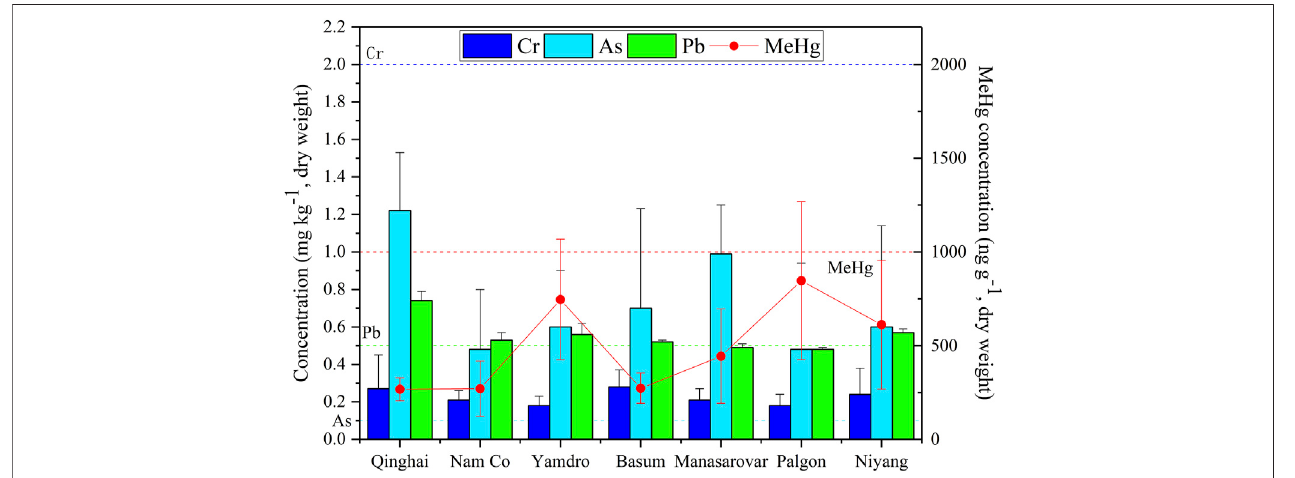
FIGURE 6 | Distribution of different lakes and rivers about HMs concentrations of wild fi shes in the TP (Yang et al., 2007; Yang et al., 2011; Yang K. et al., 2014; Shao et al., 2015). Notes: The dotted line is the maximum allowable concentration of HMs in the wild fi shes, element data are from Chinese food health criterion (MOH and SAC,